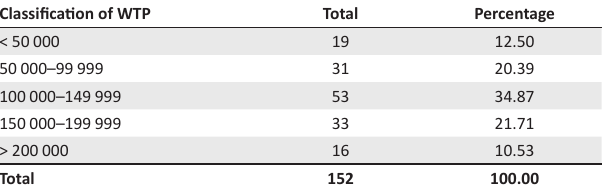
TABLE 7: The willingness to pay of flood